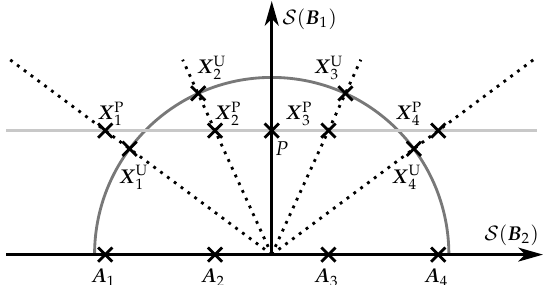
} 4 , a PSAM C P = { X P , and a i i = 1 i = 1